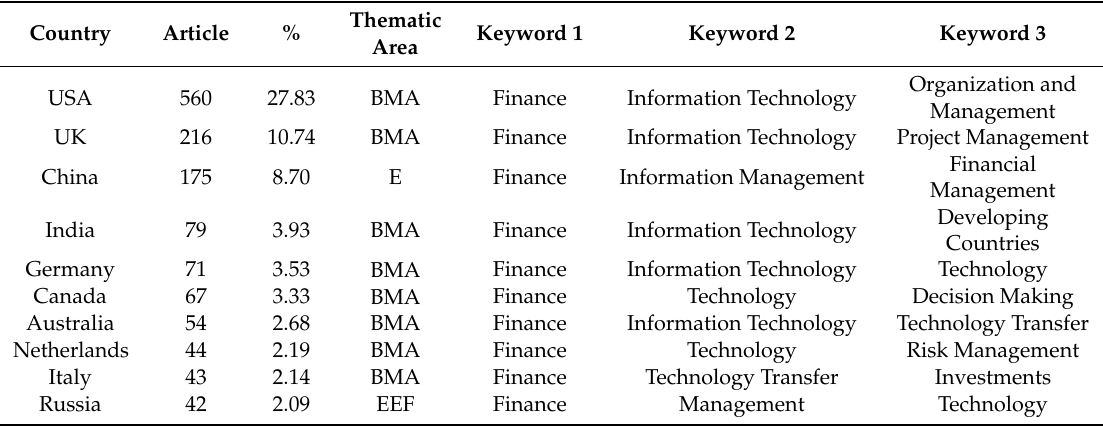
Table 14. Top 10 countries: main thematic area and keywords (1975–2019). Keyword 1 Keyword